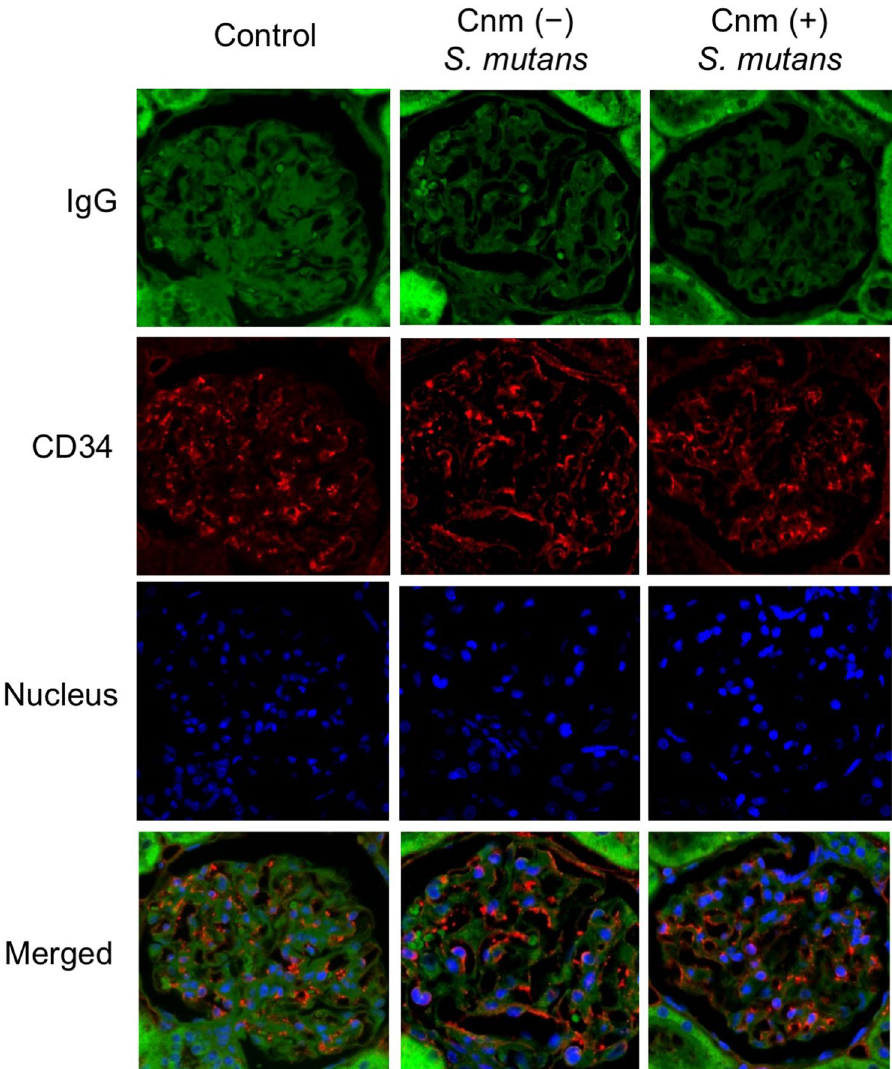
Figure 4. Representative histopathological appearance of kidney tissues by immunohistochemistry with an IgG-specific antibody. The first image shows staining with an anti-IgG antibody. The second image shows staining with an anti-CD34 antibody. The third image shows nuclear staining. The fourth row of images is superpositions of the top three